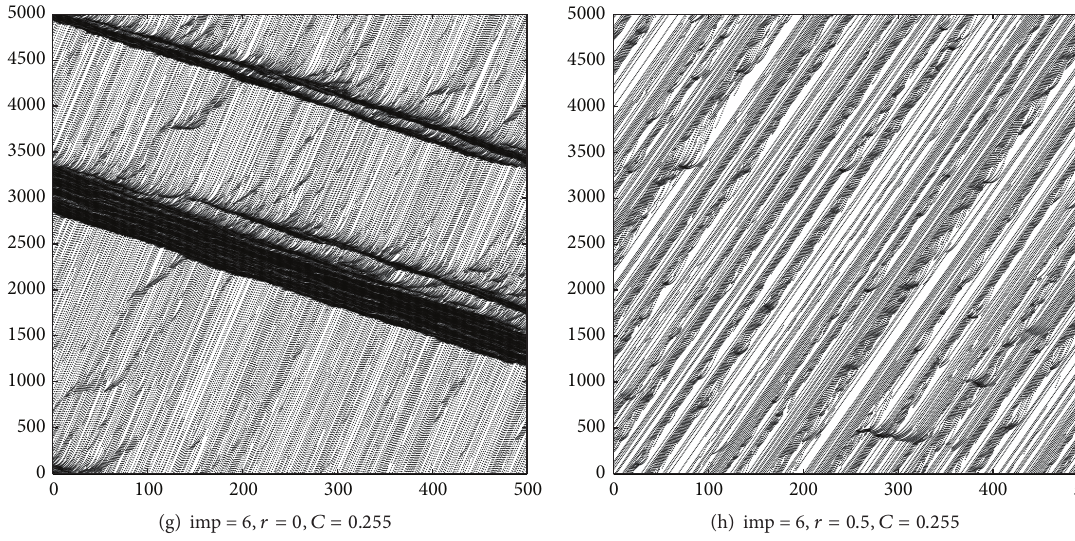
Figure 5: Spatial-temporal